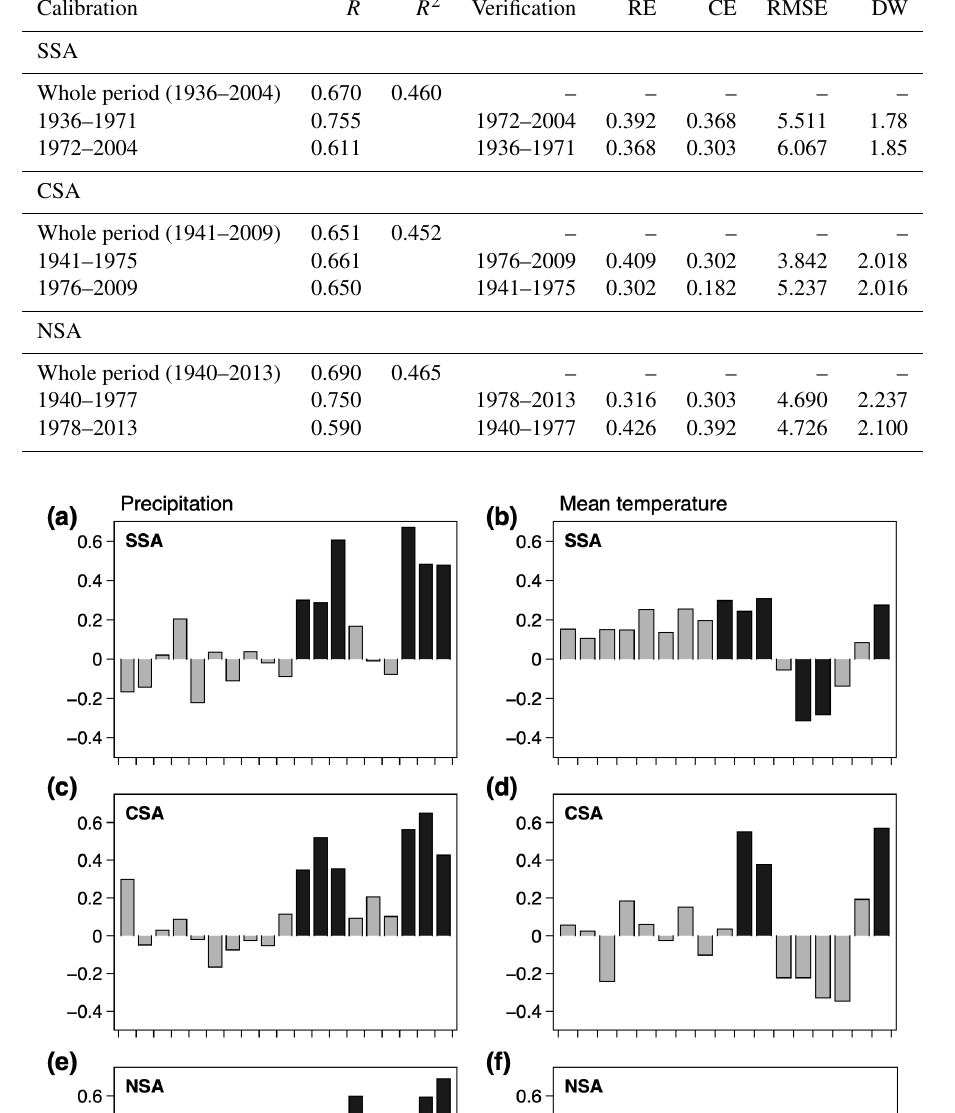
Table 2. Calibration and verification statistics of the reconstruction equations for the common periods 1936–2004 and 1941–2009.